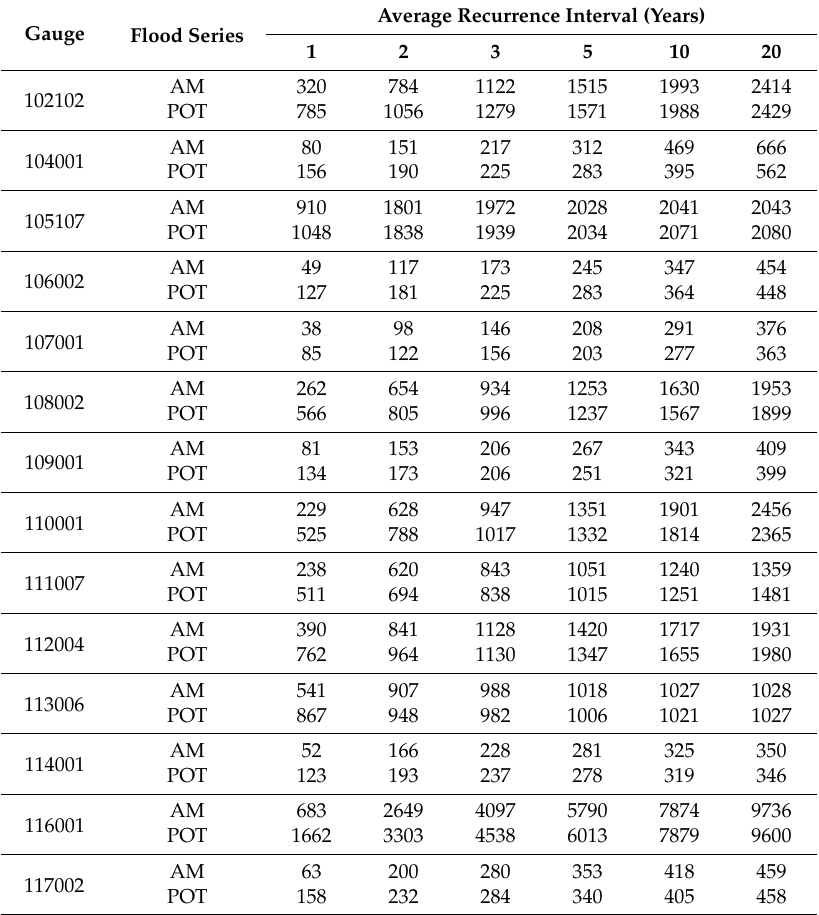
Figure 8. Comparison between observed flood data and the fitted Generalised Pareto (GPA) distribution (solid line) for the Tully catchment in north Queensland (Site ID 113006, Table 1) for ( a ) annual flood series; ( b ) peak over threshold (POT2) flood series. Using the fitted GPA model, flood magnitudes for 1, 2, 3, 5, 10 and 20 year recurrence intervals were estimated based on AM and POT series (Table 5). In most cases, flood magnitude is higher for the POT series compared to the AM series for any recurrence interval between 1 and 10 years. However, the difference is relatively larger for frequent floods (e.g., 1 and 2 years interval). Table 5. Estimated flood discharge (m 3 /s) for selected recurrence intervals using the AM and POT series for 24 gauging sites across the GBR catchments.